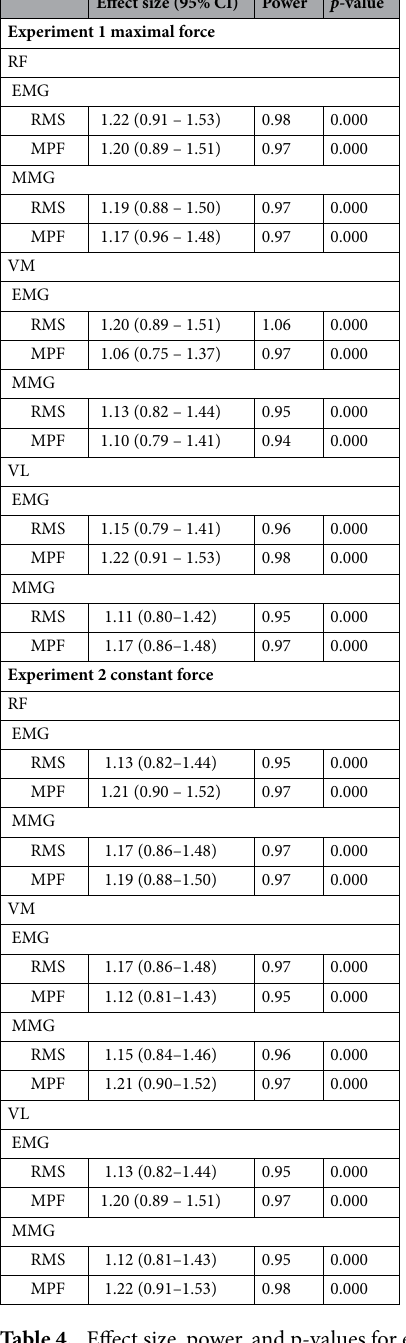
Table 4. Effect size, power, and p-values for each parameter. CI confidence interval, RF rectus femoris, VM vastus medialis, VL vastus lateralis, EMG electromyography, MMG mechanomyography, RMS root mean square, MPF mean power